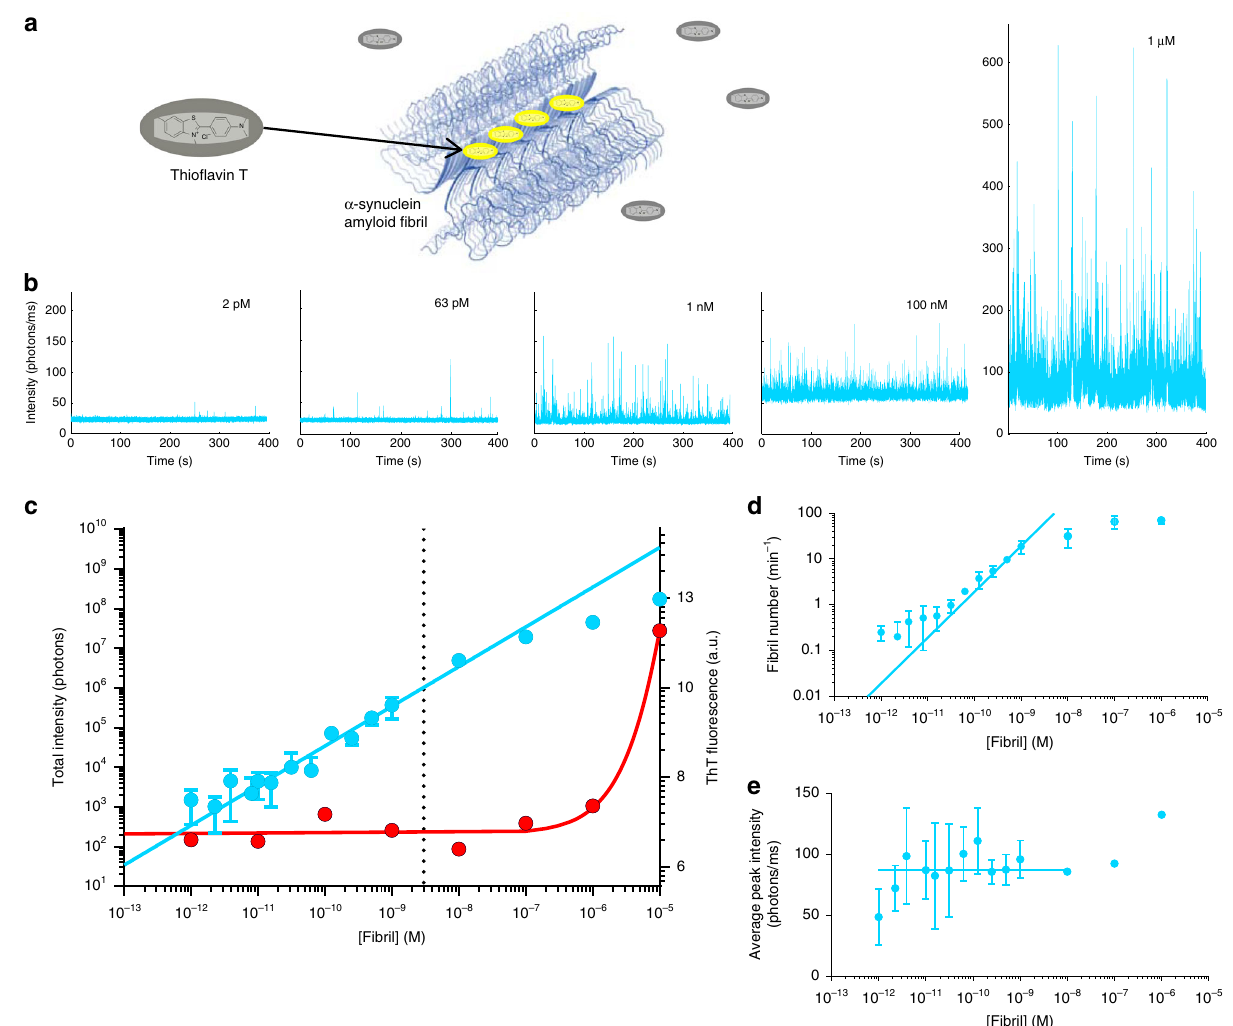
Fig. 2 Application to the detection of protein aggregates. a ThT binds speci fi cally to amyloid fi brils and increases fl uorescence upon binding. b Example traces of ThT (1 μ M ) binding to amyloid fi brils and measurement of different concentrations of mature α -syn amyloid fi brils (405 nm excitation, acquired at 100 Hz for 400 s). c Total ThT intensity detected by AttoBright (light blue) or a bulk measurement using a fl uorescence plate reader (BMG Labtech, red). For concentrations below 3 n M (dotted line), the AttoBright data are analysed by integrating individual peaks. For concentrations above 3 n M , the AttoBright data are analysed by integrating total signal intensity. The dotted line marks concentration at which individual fl uorescent bursts cannot be reliably separated. The dotted line is three orders of magnitude lower than the typical sensitivity of a bulk measurement. d , e Deconvolution of number and size of aggregates measured in c . d Number of ThT-positive species detected by AttoBright across serial fi bril dilutions. Linear range ~ 10 − 11 – 10 − 9 M . e Average peak intensity remains constant with fi bril length across a wide range of concentrations (~ 10 − 11 – 10 -8 M ). Error bars are mean ± s.d of 3 × 400 s